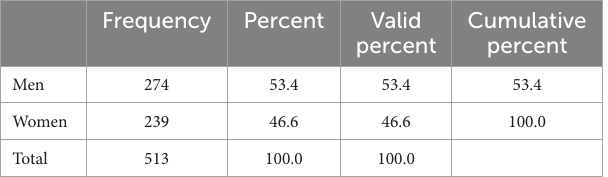
TABLE 1 Demographics of the